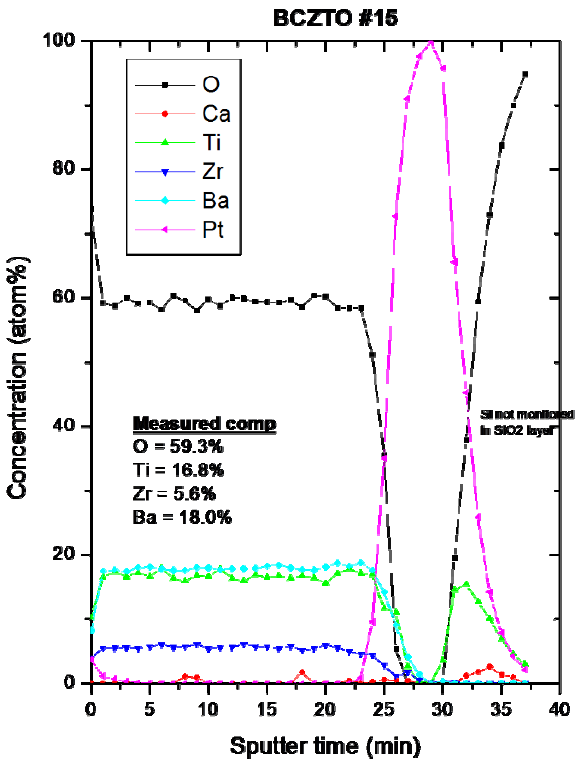
Figure 7. Depth profile XPS of ~500 nm thick BCZTO film with Pt electrodes. Sample area was ~600 μ m square, located between patterned top electrode